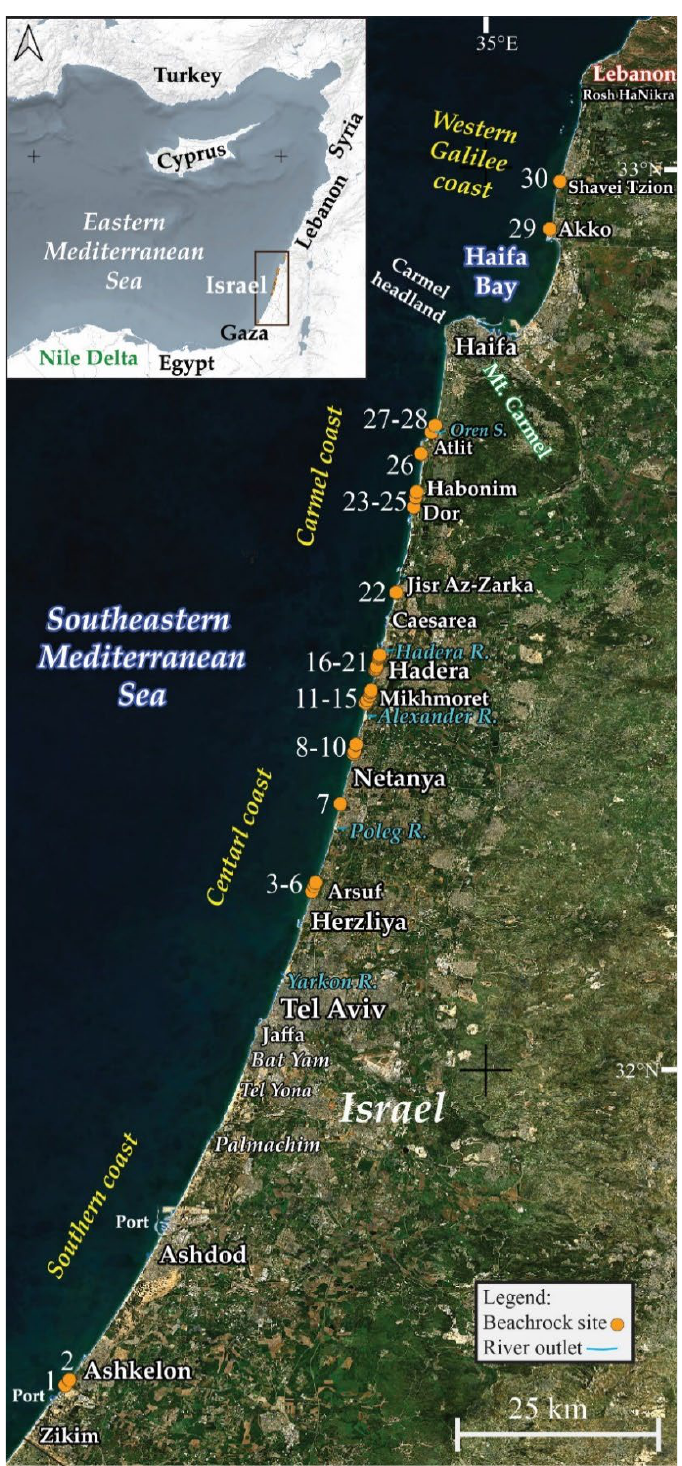
Figure 2. The eastern Mediterranean (top left) (Map details: Middle East Mediterranean coast: terrain light background layer by EOX—4326); and the Mediterranean coast of Israel: showing the location of selected BR outcrops discussed in this paper, and relevant geographic features (details: background map: Sentinel-2 cloudless layer for 2020 by EOX– 4326).